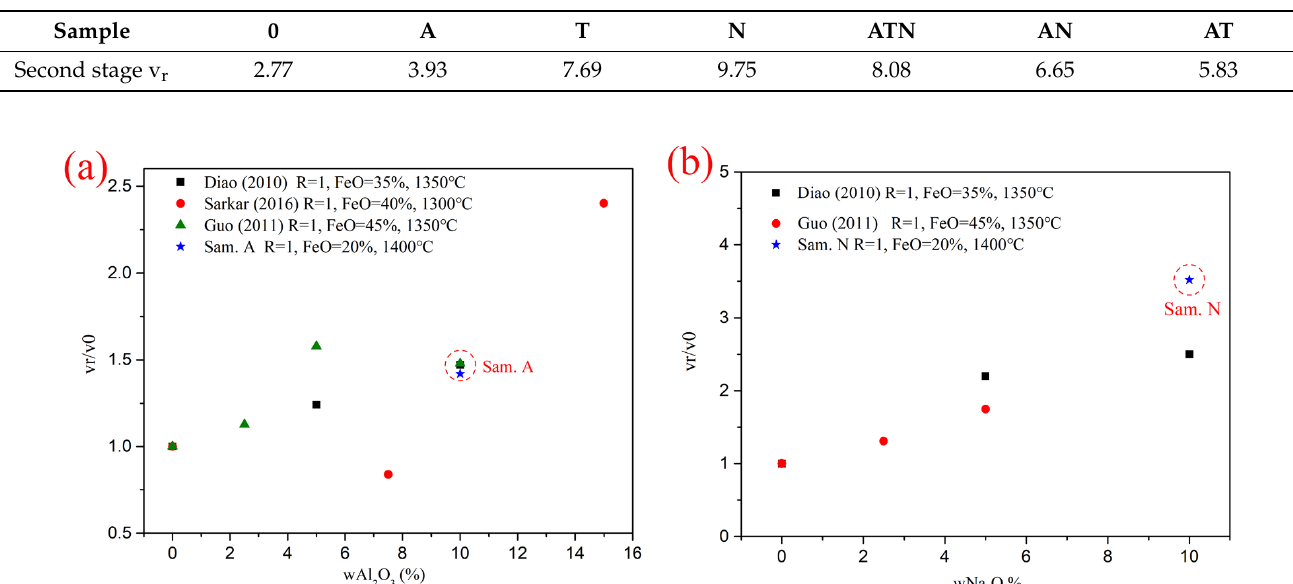
Figure 6. Comparison of dissolution rates of lime in the existing literature with experimental dissolution rates obtained here (( a ) add Al 2 O 3 [15–17], ( b ) add Na 2 O [15,16]) (v r is the lime dissolution rate after adding Al 2 O 3 /TiO 2 /Na 2 O; v 0 is the lime dissolution rate before adding Al 2 O 3 /TiO 2 /Na 2 O). Table 2. Dissolution rate of lime (10 –5 cm/s).